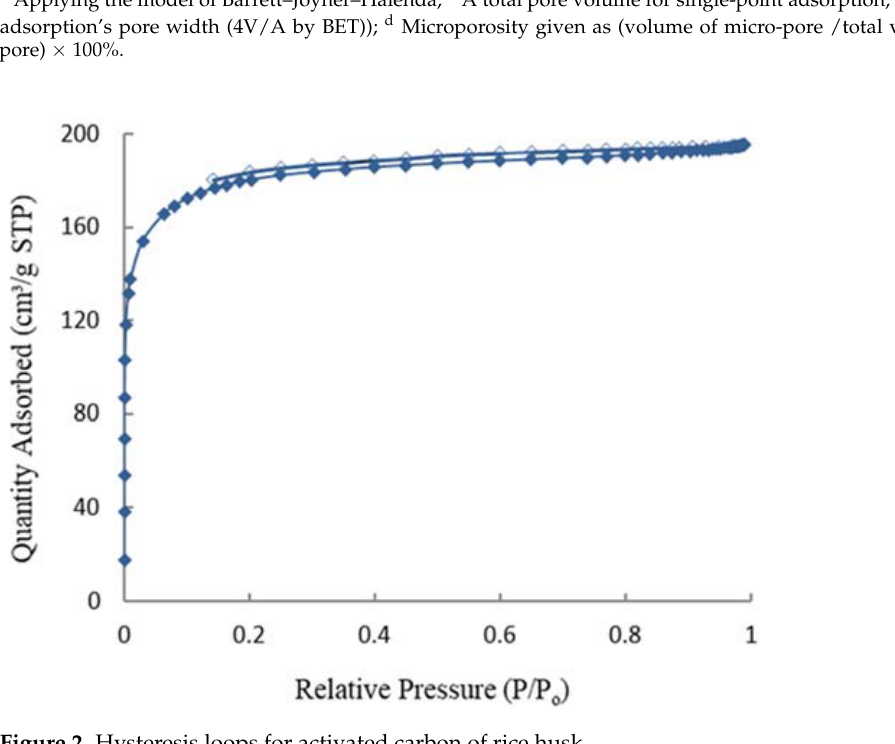
Figure 2. Hysteresis loops for activated carbon of rice husk.